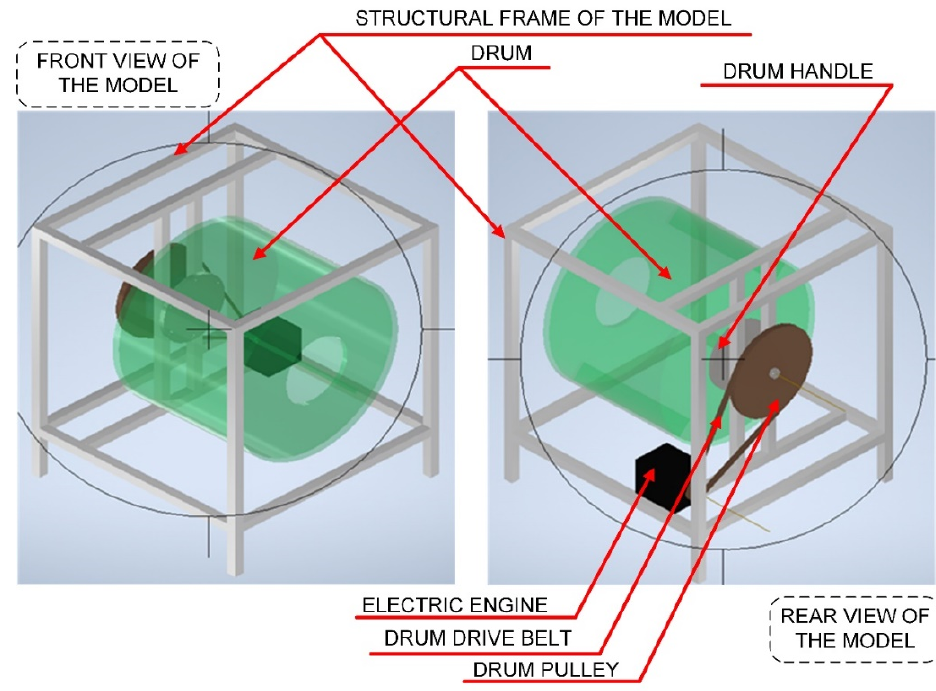
Figure 8. Developed device housing model.